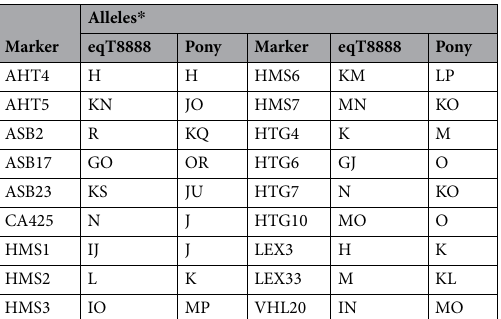
Table 2. Equine DNA profile of eqT8888 cell line and a control pony. * According to the assignment on International Society of Animal Genetics (ISAG) horse comparison